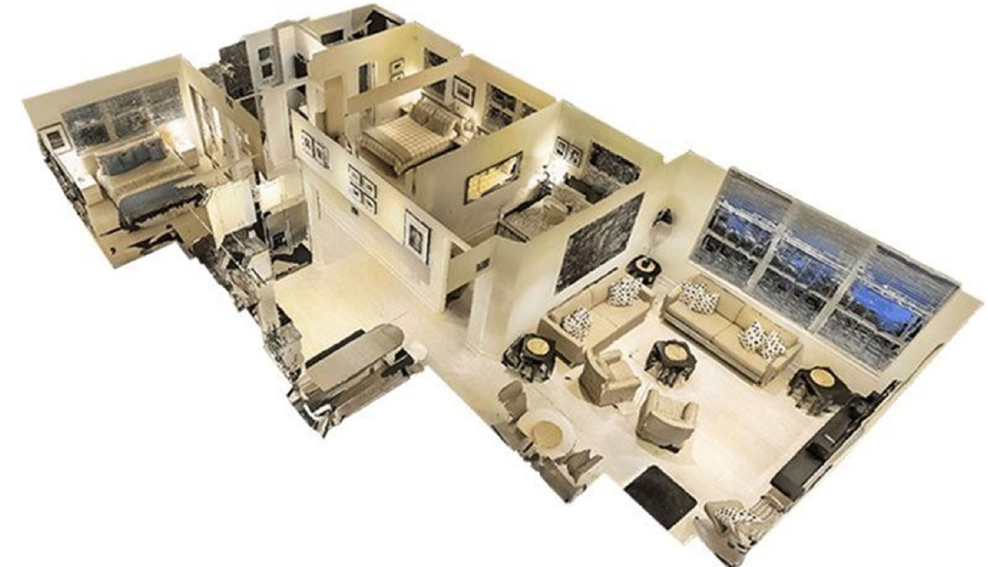
Figure 4. 3D of space. Reprinted/adapted with permission [80]. 2022,